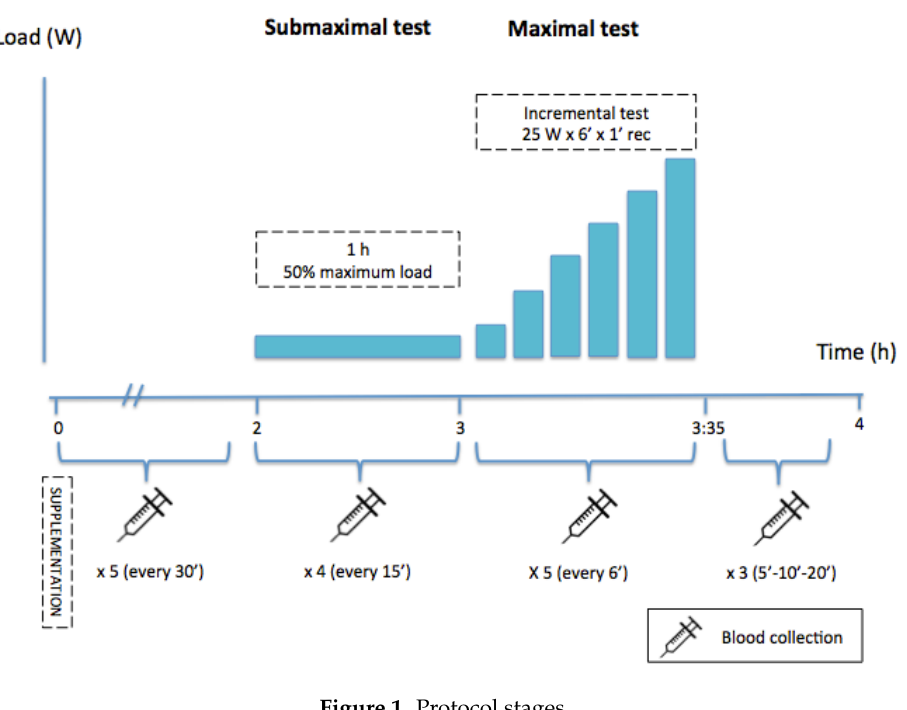
Figure 1. Protocol stages.